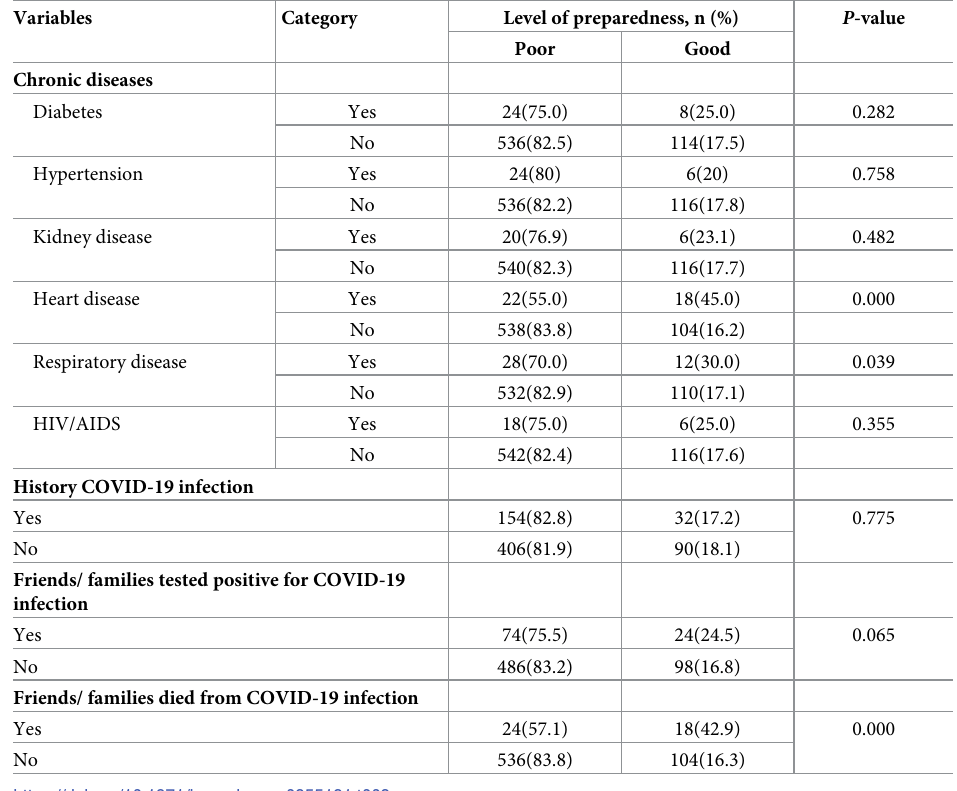
Table 2. Chronic diseases and history of COVID-19 infection by the level of preparedness in DBU,